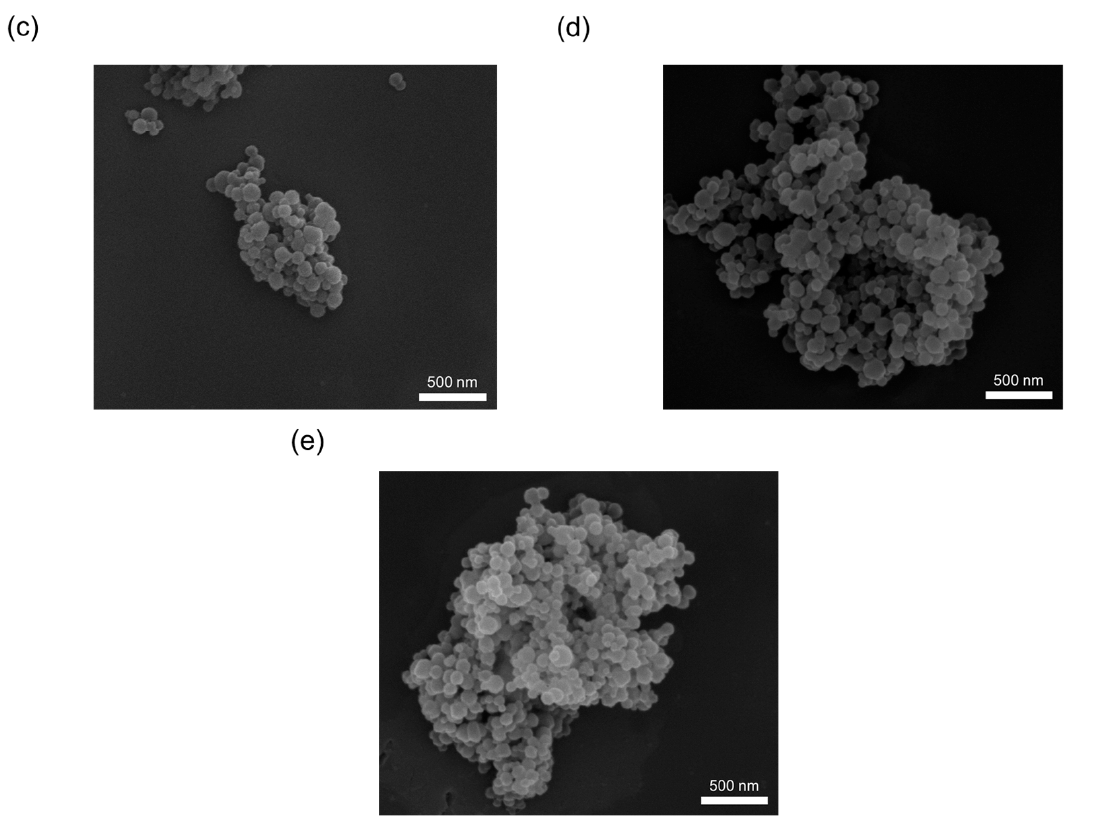
Figure 8. The SEM images of ZIF-8 samples with de novo- synthesis and impregnation methods using Ag 2 CO 3 as the precursor. ( a ) 01AgCO@ZIF (de novo), ( b ) 09AgCO@ZIF (de novo), ( c ) 25AgCO@ZIF (de novo), ( d ) 10AgCO/ZIF (impregnation), ( e ) 50AgNO/ZIF (impregnation).